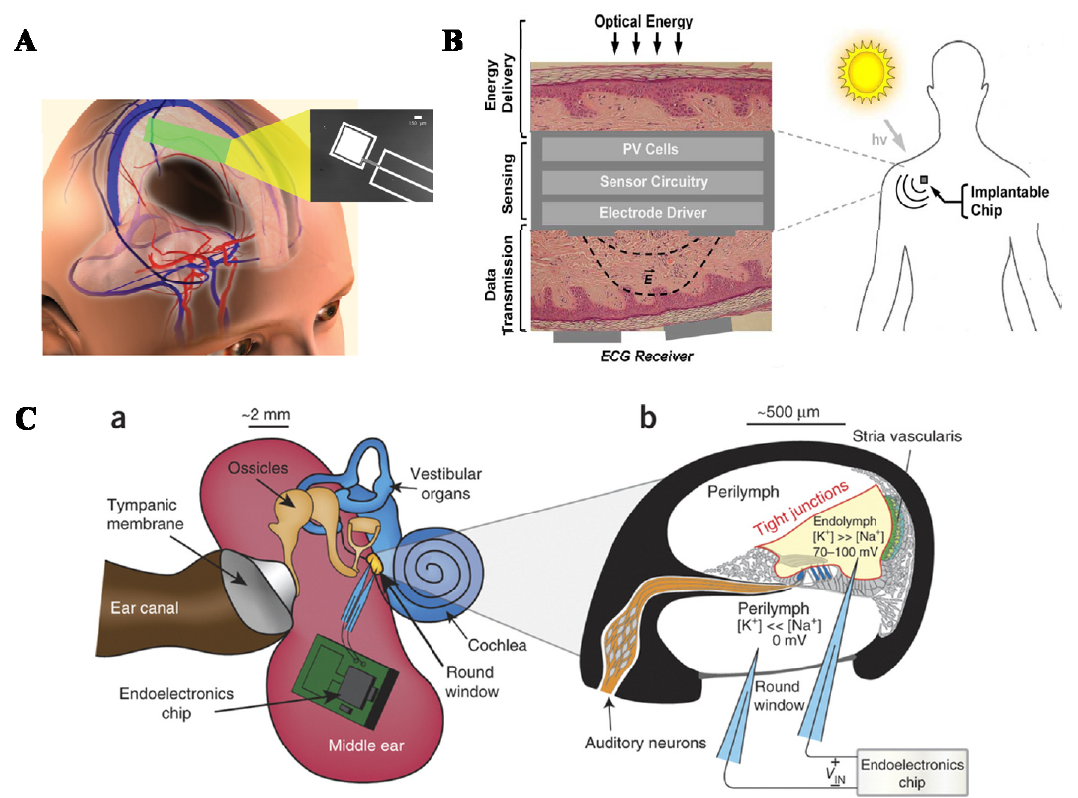
Figure 2. ( A ) Power extraction from cerebrospinal fluid by an implantable glucose fuel cell: plausible site of implantation within the subarachnoid space and a micrograph of one prototype, showing the metal layers of the anode (central electrode) and cathode contact (outer ring) patterned on a silicon wafer [21]. ( B ) A photovoltaic-driven energy-autonomous CMOS implantable sensor [103]. ( C ) An anatomically sized chip that harvests the energy of the electrochemical potential in the guinea pig cochlea to power a wireless transmitter: ( a ) plausible site of implantation within the mammalian ear; ( b ) cross-section of a typical cochlear half-turn, showing the endolymphatic space (yellow) bordered by tight junctions (red), the stria vascularis (green) and hair cells (blue), which are contacted by primary auditory neurons (orange)